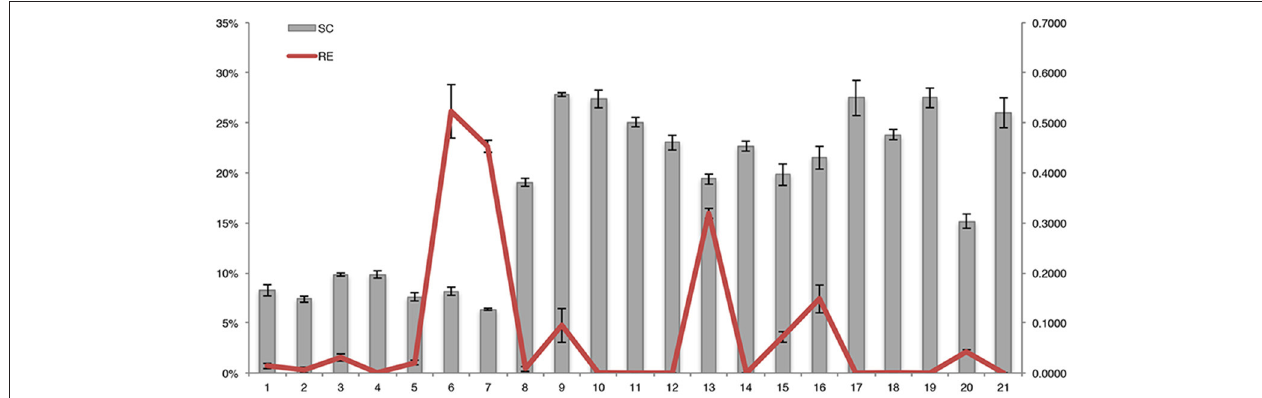
FIGURE 7 | Dynamic changes in the starch content and the expression pattern of Ib β fruct2 during SR development in the three sweet potato varieties. SC, starch content per SR fresh weight; RE, relative expression ( 1 Ct) of Ib β fruct2.